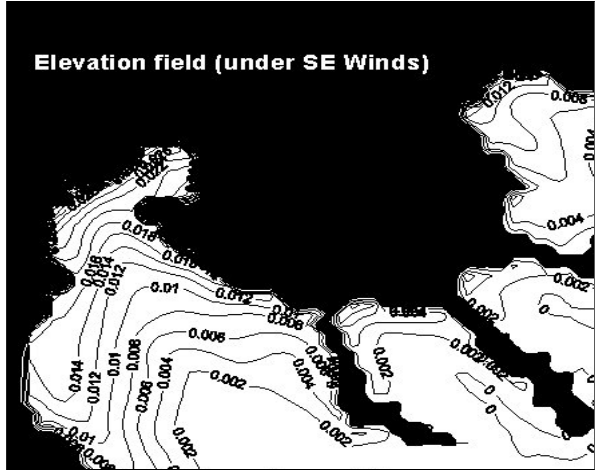
Fig. 9. Surface Elevation field due to southeastern winds (22 September 2002).